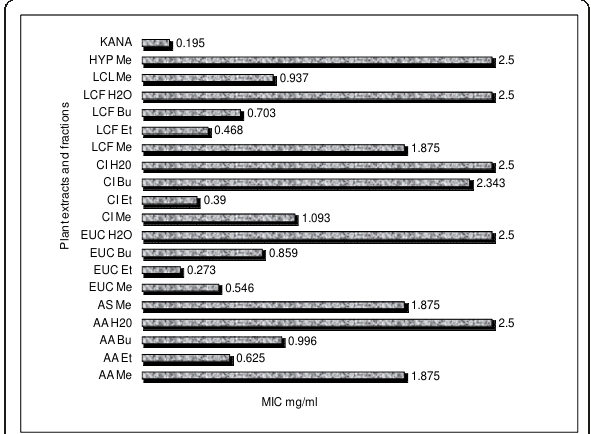
Figure 1 Minimum inhibitory concentration of plant extracts and fractions . AA Me = Methanol fraction of A. arborescens (AA) ; AA Et = Ethyl acetate fraction of AA; AA Bu = n-Butanol fraction of AA ; AA H2O = Water fraction of AA; AS Me = Methanol fraction of A. striata ; EUC Me = Methanol fraction of E. autumnalis (EA); EUC Et = Ethyl acetate fraction of EA ; EUC Bu = n-Butanol fraction of EA ; EUC H2O = Water fraction of EA ; CI Me = Methanol fraction of C. uncinulata (CU); Et = Ethyl acetate fraction of CU ; CI Bu = n-Butanol fraction of CU ; CI H2O = Water fraction of CU ; LCF Me = Methanol fraction of L. camara fruit/flower (LCF) ; LCF Et = Ethyl acetate fraction of LCF ; LCF Bu = n-Butanol fraction of LCF ; LCF H2O = LCF Water fraction of LCF ; LCL Me = Methanol fraction of L. camara leaves; HYP Me = HYP Methanol